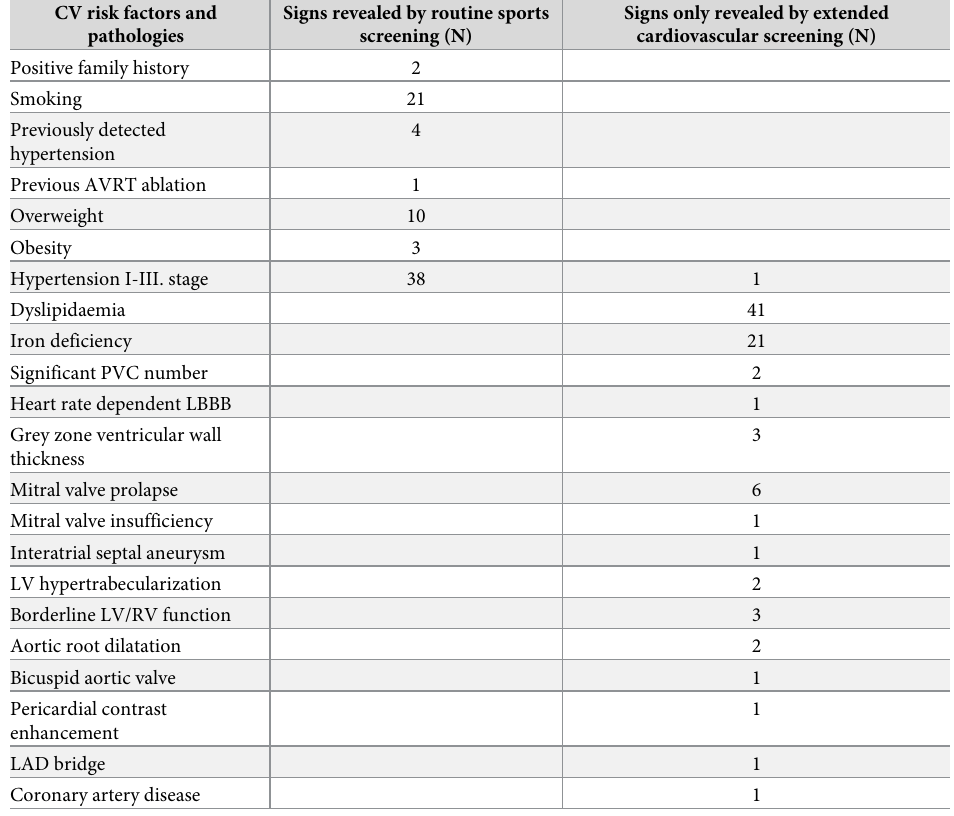
Table 5. Number of CV risk factors and pathologies of the handball referees revealed by routine sports screening and extended cardiovascular screening. CV risk factors and Signs revealed by routine sports pathologies screening (N)